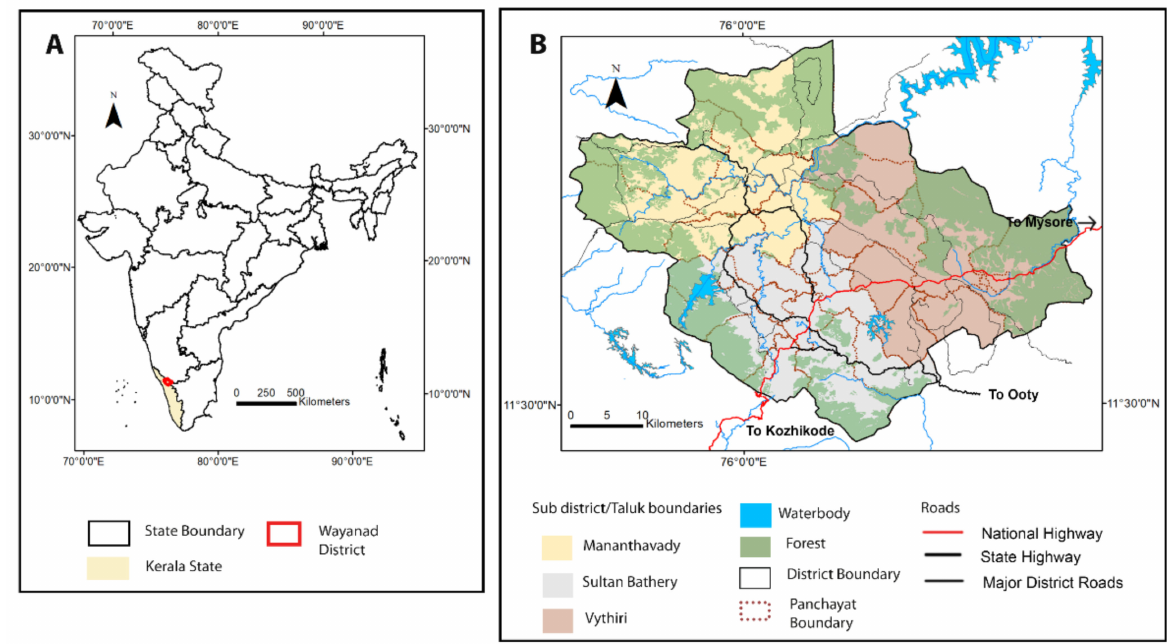
Figure 1. ( A ) Location of Wayanad district in Kerala within the Indian boundary. ( B ) Base map of Wayanad district showing major subdistricts and land